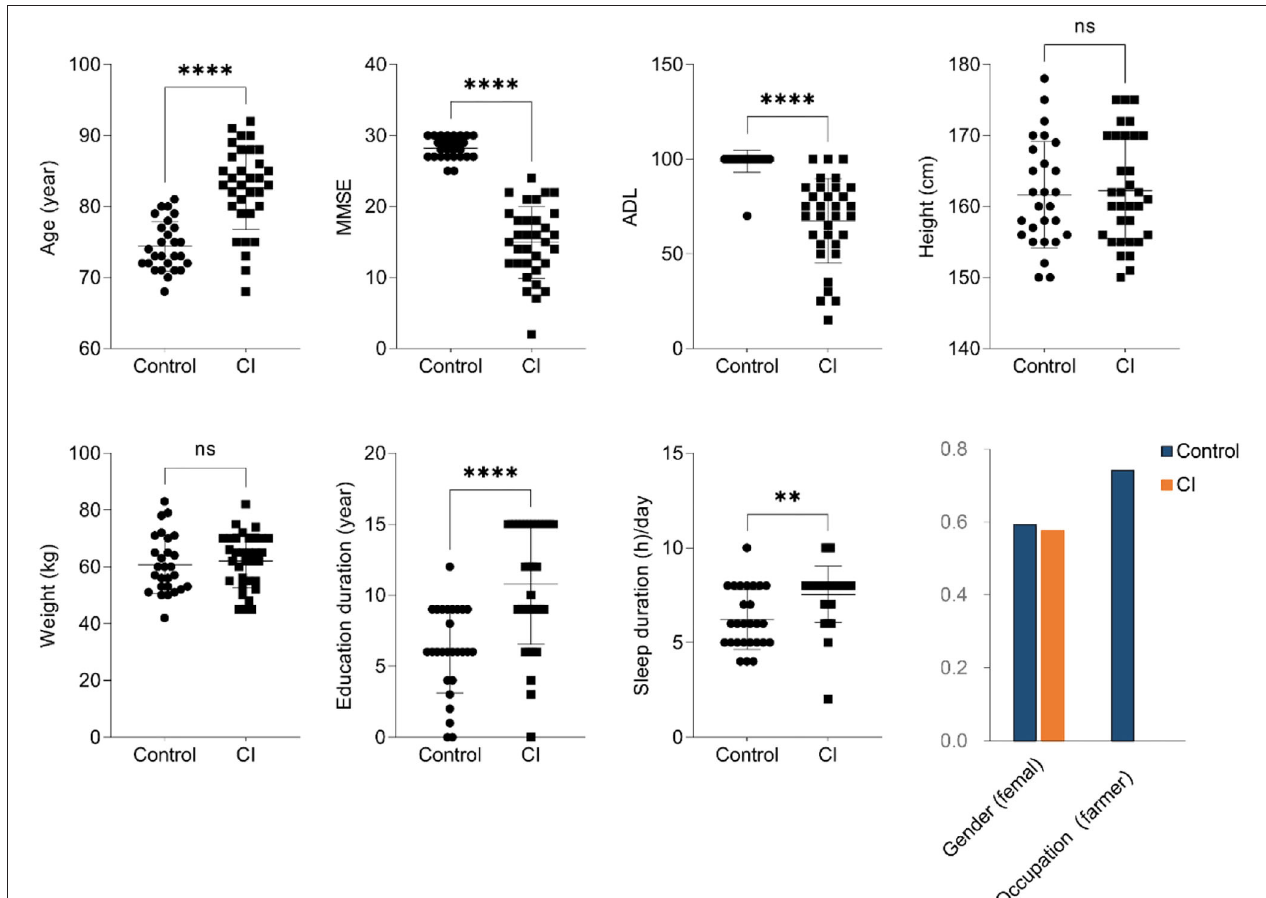
FIGURE 1 | Baseline clinical characteristics (unpaired t -test, ns, no significance, ** p < 0.01, **** p < 0.0001).